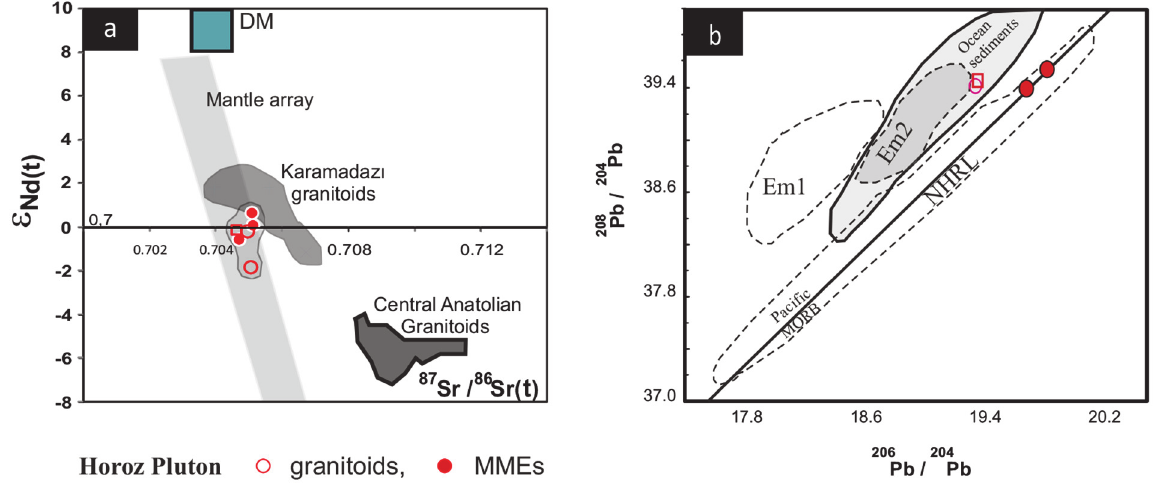
Fig. 8. (a) ( 87 Sr/ 86 Sr)t vs ɛ Nd(t) plot of the Horoz and Karamadaz ı granitoids and their mafic enclaves. Composition fields for Karamadaz ı granitoids from Kocak (2008), for Central Anatolian granitoids from Ilbeyli et al. (2004). DM, depleted mantle. (b) ( 206 Pb/ 204 Pb) vs ( 208 Pb/ 204 Pb) variation diagram of the Horoz samples. Northern Hemisphere Reference Line (NHRL) indicated (Hart